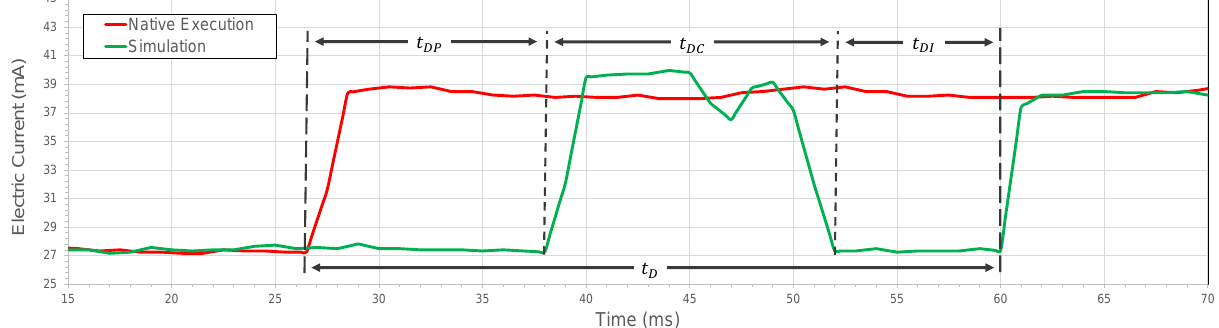
Figure 22. Comparison of the delay between the native execution based on FreeRTOS (red line) and the DPA (green line) based on simulation data for a software application to activate a GPIO